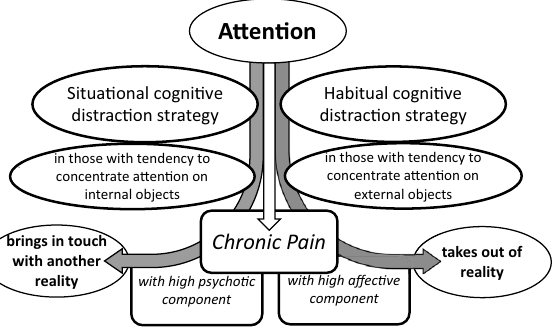
Figure 2. A schema of situational and habitual cognitive distraction mechanisms redirecting attention from the pain experience with a high psychotic-like or high affective component to other dominant, real or unreal events in individuals with tendencies to concentrate attention on internal or external objects, respectively, thus reducing pain severity and need for pain